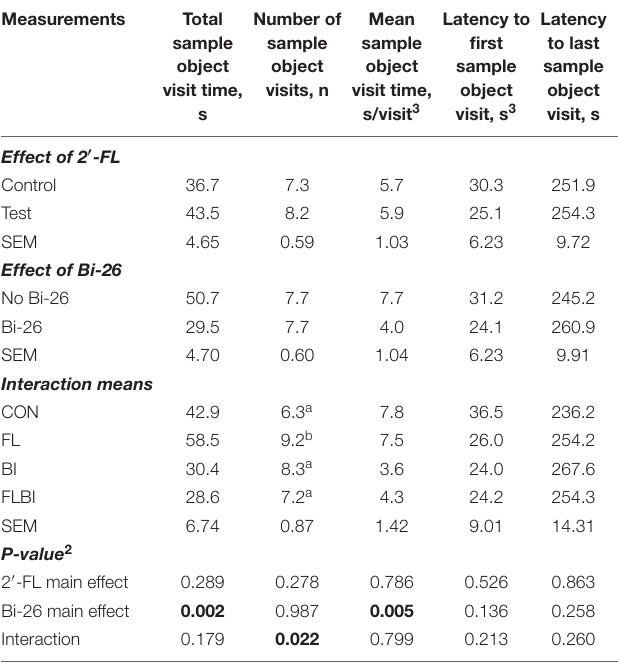
TABLE 5 | Exploratory behavior of the sample (familiar) object during the test trial of the NOR task 1 .